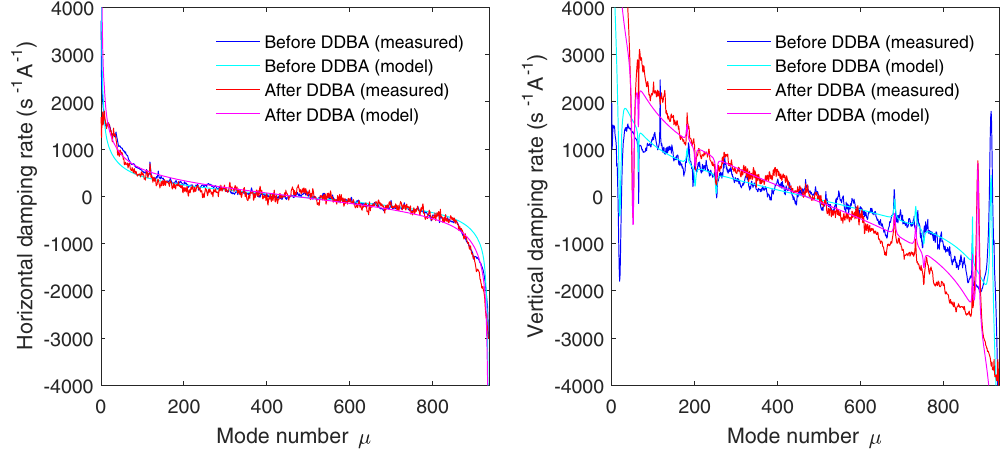
FIG. 13. Horizontal (left) and vertical (right) damping rates normalized to bunch current before and after the installation of the DDBA